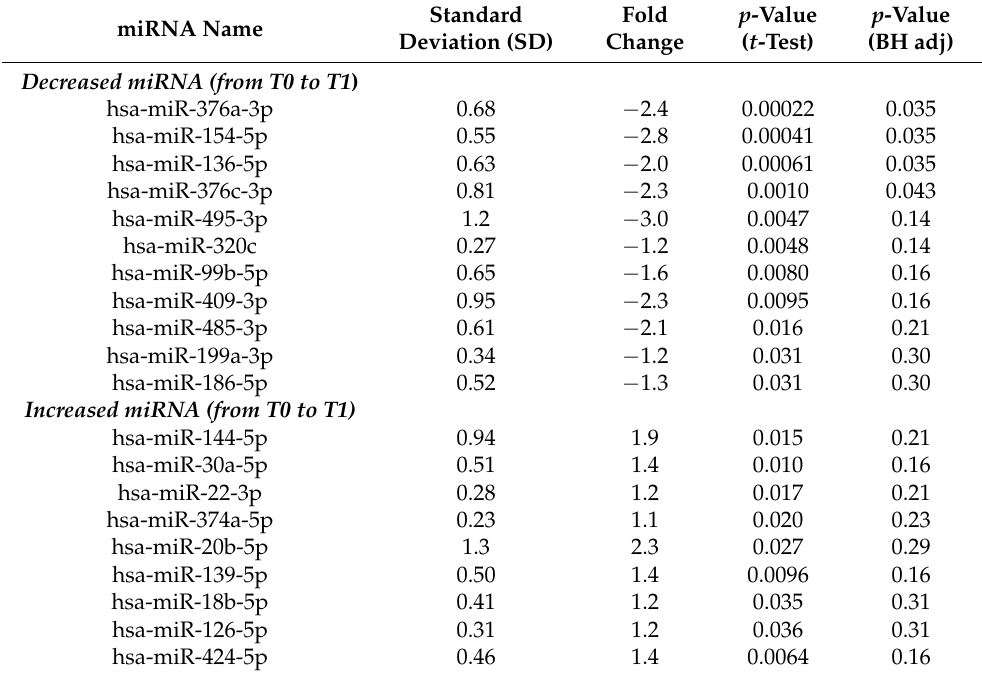
Table 3. Top most differentially expressed miRNAs between T1 and T0. SD, Standard deviation across the groups; fold changes between the two groups; p -value, t -test; adjusted p -value, Benjamini– Hochberg-adjusted (BH adj)